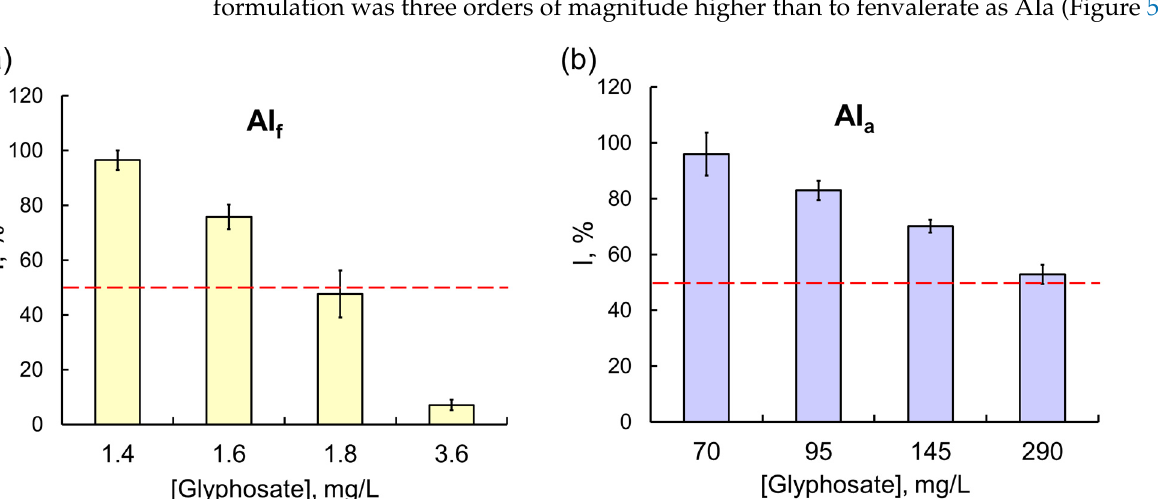
Figure 5. The effects of ( a ) the Sempay commercial pesticide formulation (with fenvalerate as the active ingredient) and ( b ) fenvalerate as AIa on the Red + Luc coupled enzyme system. The same as for glyphosate, the inhibitory effect of fenvalerate as AIf on the Red + Luc system was stronger than the effect of fenvalerate as AIa; the values of IC 50 for fenvalerate as AIf and AIa were 0.0014 and 4.8 mg/L, respectively. The comparison of the effects of AIas and AIfs on assay systems suggested a consid- erable contribution of additional components to the inhibitory effect of the pesticide for- mulation. For example, the imidacloprid neonicotinoid used as AIa did not produce any detectable effect either on enzyme activity or on intensity of bioluminescence of the lumi- nous bacterium regardless of its concentration within the tested range (Table 1). However, commercial pesticide formulations based on imidacloprid demonstrated noticeable inhib- itory effects on assay systems: high sensitivity to imidacloprid MRLs in fruit and vegeta- bles was observed in experiments with single-enzyme reactions based on ADH, Red, and LDH and all multi-enzyme reactions. The contribution of formulants to inhibition of enzymatic assay systems was addi- tionally supported by the differences in IC 50 that we previously found for commercial pes-